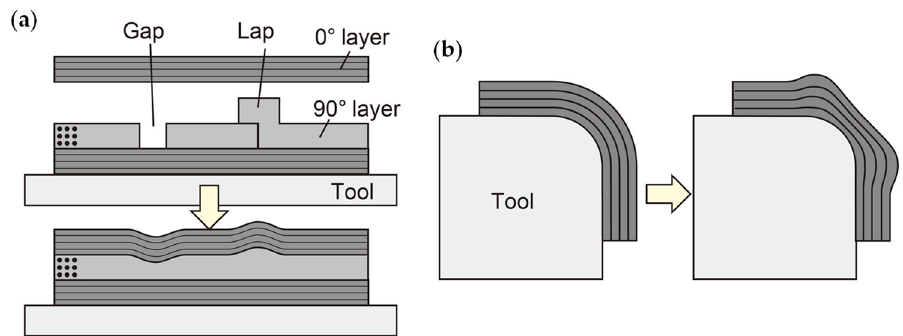
Figure 1. Consolidation of composite laminate with gap/lap ( a ) and composite corner part ( b ).